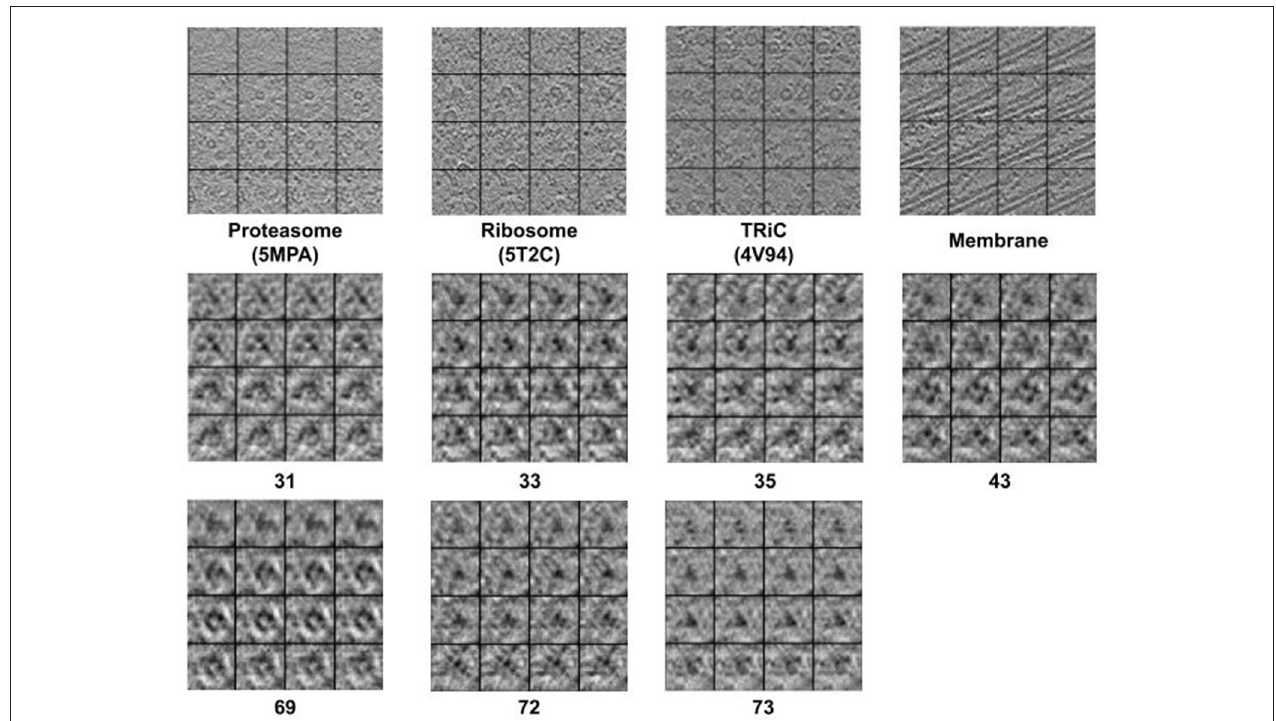
FIGURE 2 | The 2D slide visualization of generated subtomograms ( Top : S e 1 , Middle and Bottom : S e 2 ). In general, we find CryoETGAN retrieval produces qualitatively similar subtomogram compared to the ground truth and is capable of producing various classes without mode collapse.